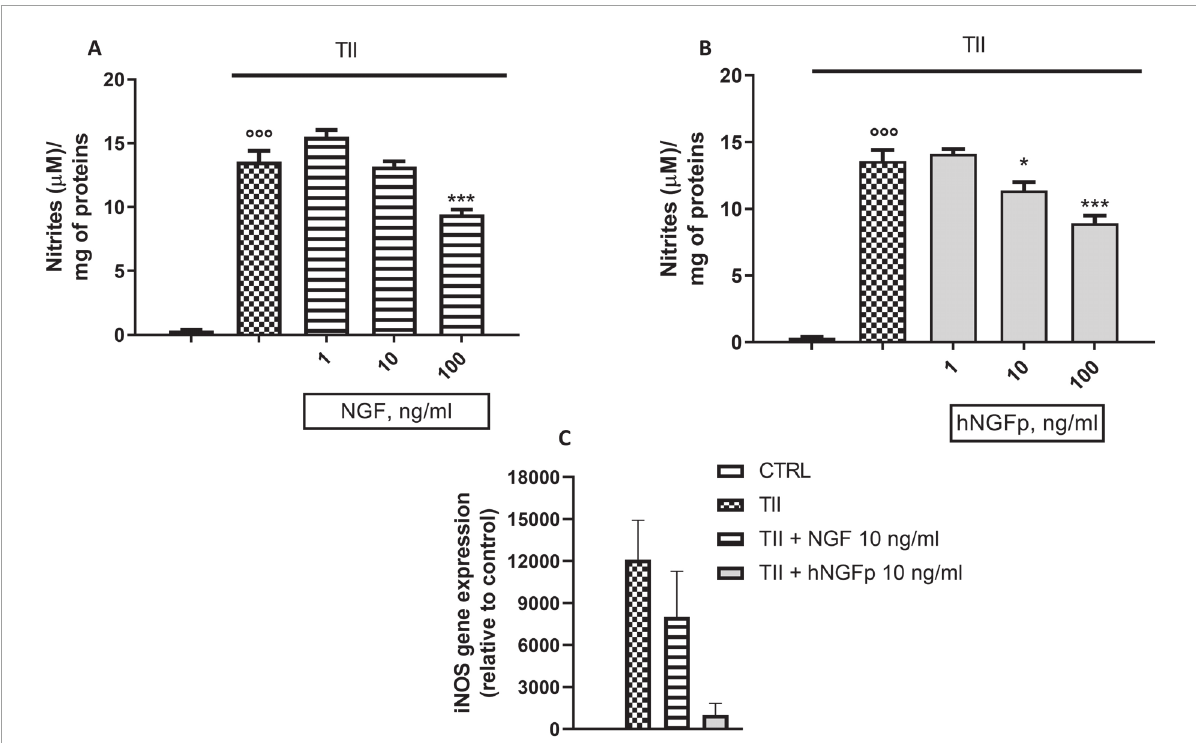
FIGURE5 Effects on inducible nitric oxide synthase (iNOS) pathway after 48 h nerve growth factor (NGF) treatments. CHME-5 were treated with TII for 48 h. (A) The effects of 1–10 or 100 ng/ml of wild type Nerve Growth Factor (NGF) on nitrite production in CHME-5. (B) The effects of 1–10 or 100 ng/ml of painless human NGF on nitrite production in CHME-5. (C) iNOS expression after 24 h of treatment. ◦◦◦ p < 0.001 vs. control, * p < 0.05 and *** p < 0.001 vs. TII. One-way ANOVA analysis followed by Bonferroni’s post-test was carried out. (A) F (4, 25) = 101.2; P < 0.0001. (B) F (4, 25) = 141.2; P < 0.0001. Data are expressed as mean ± SEM. The experiment was repeated four times with similar